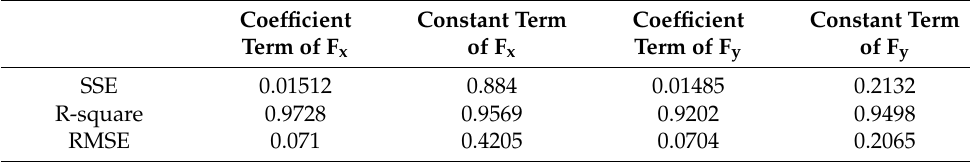
Table 5. Fit results of force parameters.